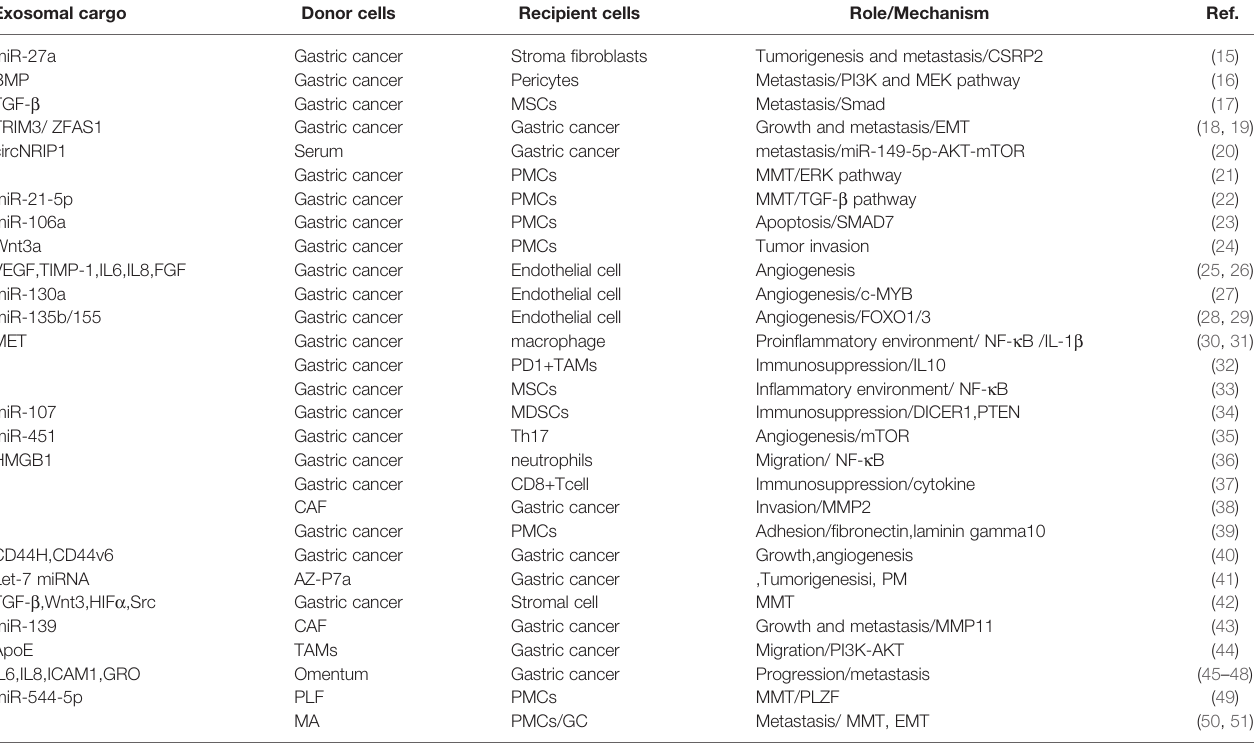
TABLE 1 | Function of exosomes in progression and peritoneal metastasis. Exosomal cargo Donor cells Recipient